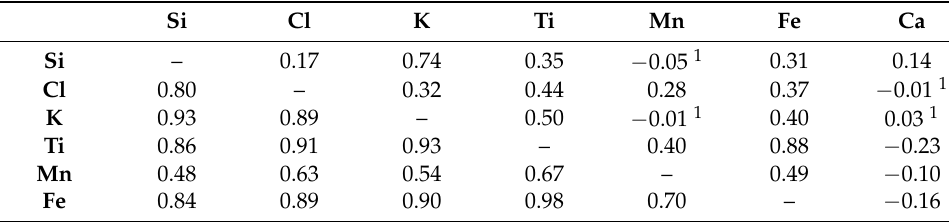
1 all coefficients are significant at p < 0.01 level, except for these four values. The upper triangle is based on original data, while the lower is based on the record normalized by Ca